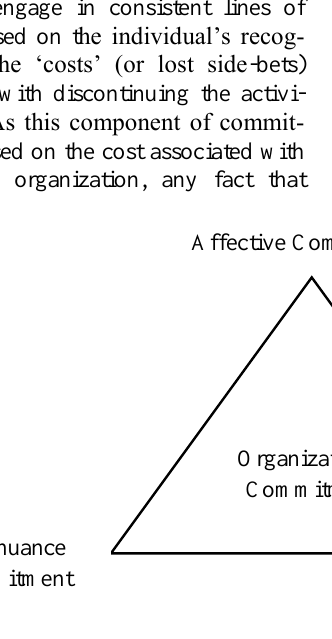
Fig. 2 The Three component model of Organizational Commitment Source: Adapted from “The effect of spiritual values on employees’ organizational commitment and its models” by M.R. Dehaghi, M. Goodarzi and Z.K. Arazi, 2012, Procedia-Social and